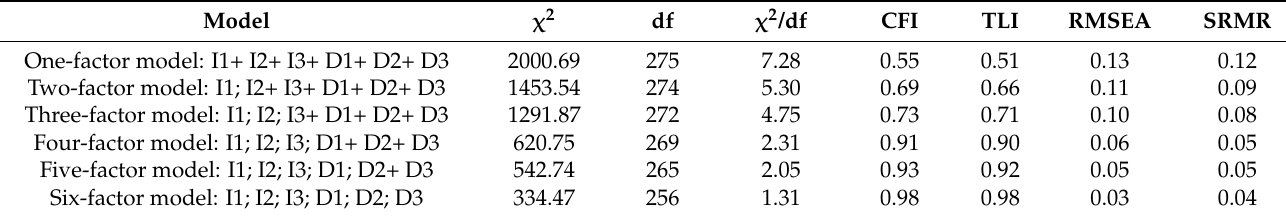
Table 2. Results of differentiated validity test and common method bias analysis.